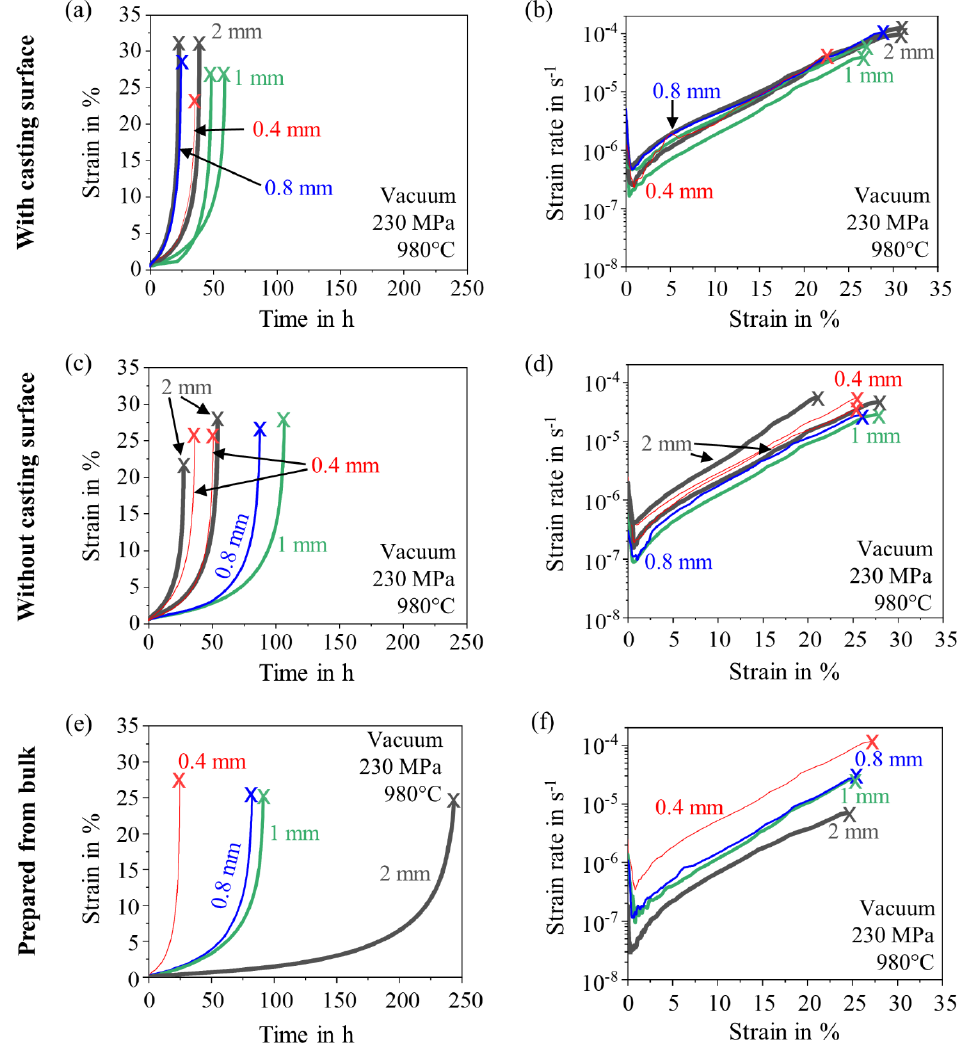
Figure 8. Creep curves of thin-walled specimens for the investigation of the influence of the wall thickness under vacuum at a stress of 230 MPa at 980 °C: ( a , b ) with casting surface, ( c , d ) without casting surface, ( e , f ) prepared from bulk